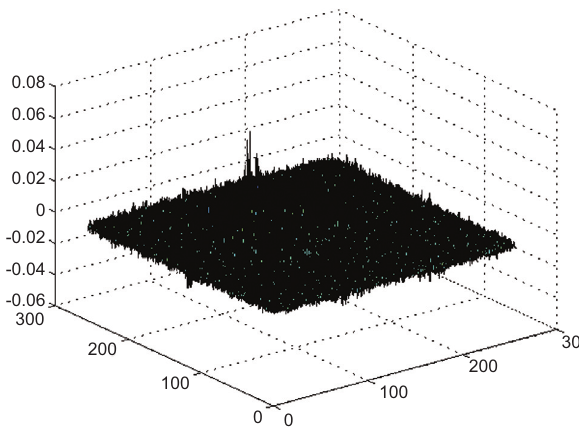
Figure 25. Surf Plot of Phase Correlation for Test Image2.